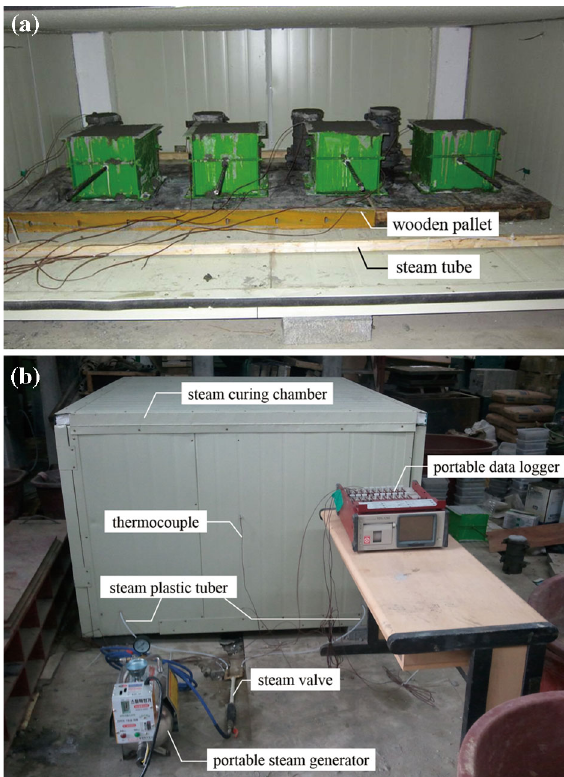
Fig. 3 Steam curing chamber. a Placement of pull-out spec- imens in the curing chamber and b test setup for curing and data